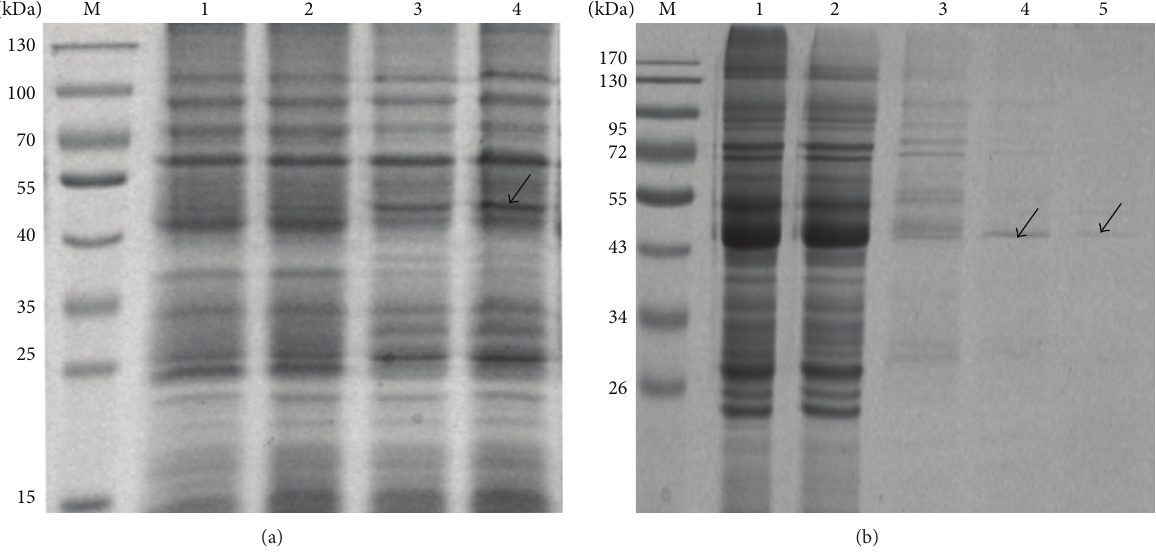
Figure 9: Fab expression and purification. (a) SDS-PAGE: 1, pComb3 clone was induced by 0.5 mM IPTG at 28 ∘ C for 8h; 2, number 29 was not induced; 3, number 29 was induced by 0.5 mM IPTG at 28 ∘ C for 6h; 4, number 29 was induced by 0.5mM IPTG at 28 ∘ C for 8h. (b) SDS-PAGE: 1, sample before passing HiTrap Protein L column; 2, sample after passing HiTrap Protein L column; 3, the washout of the HiTrap Protein L column with binding buffer; 4, the washout of the HiTrap Protein L column with sodium acetate buffer (pH